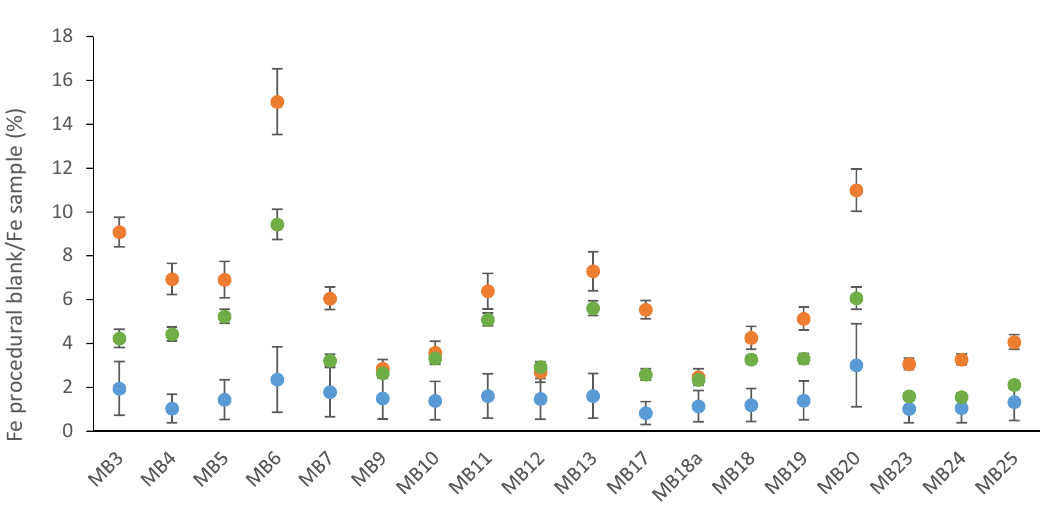
Figure A2. Contribution of procedural blanks to the Fe content in the samples for soluble (blue), leachable (green), and refractory (orange) fractions. Error bars calculated based on single standard deviations between separated PB’s collected in Mission Beach.